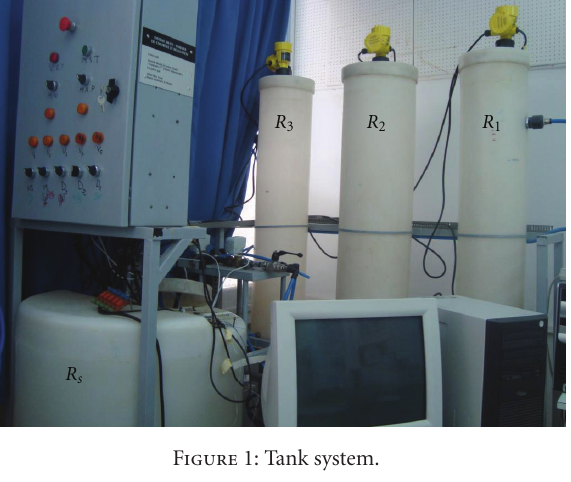
Figure 3: Water levels h 1 and h 2 in tanks R 1 and R 2 .